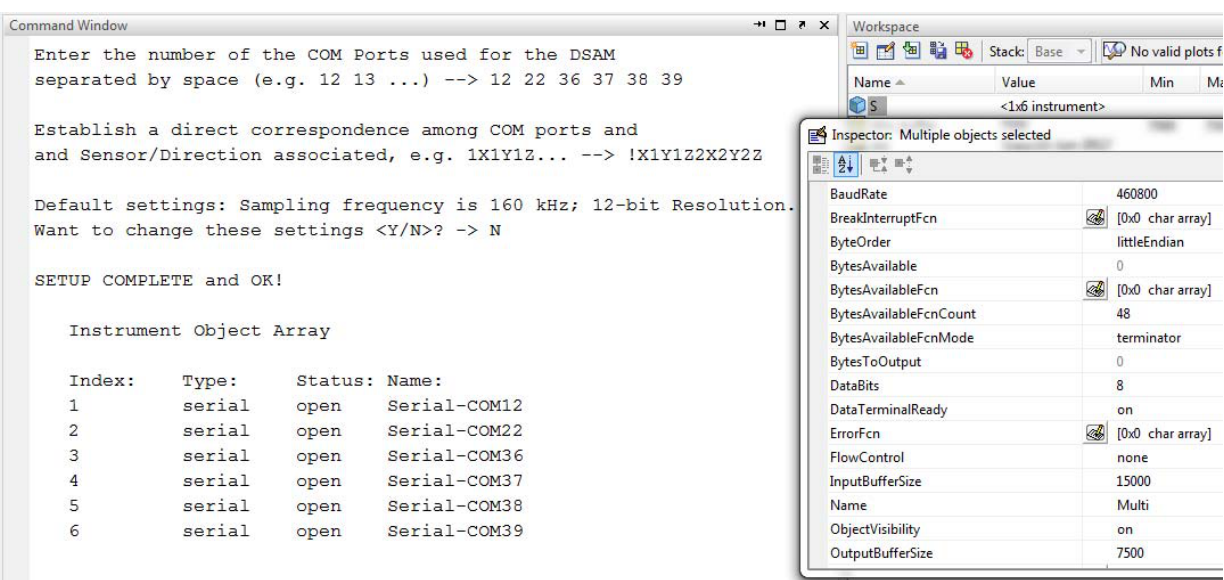
Figure 9. Diagram of the IS module